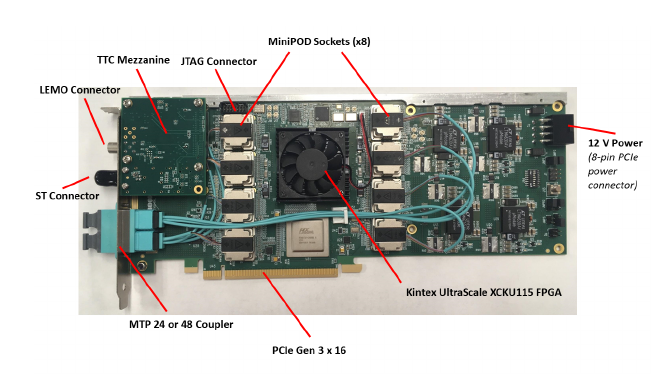
Figure 2. Photograph of a FLX-712 card with key components